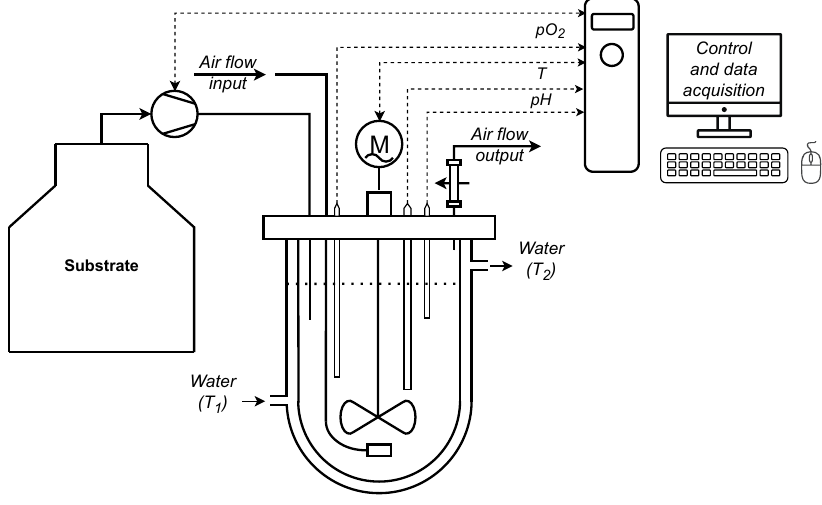
Figure 1. Experimental setup of the